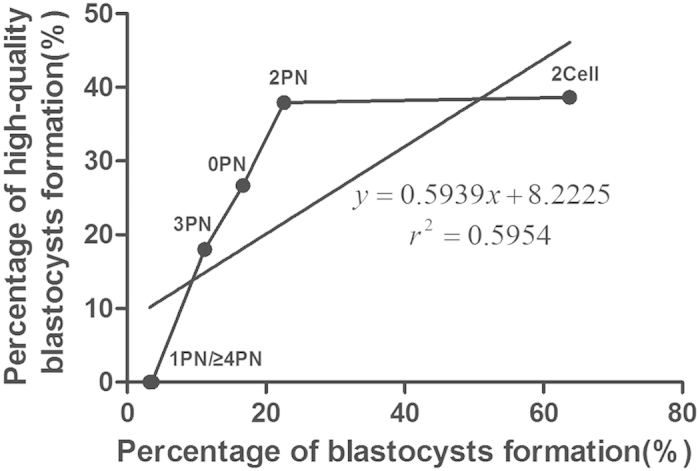
Correlation between percentages of blastocyst formation and high-quality blastocyst formation from different zygotes and prematurely cleaved 2Cell embryos.Percentages are of blastocyst formation (x-axis) and high-quality blastocyst formation (y-axis).